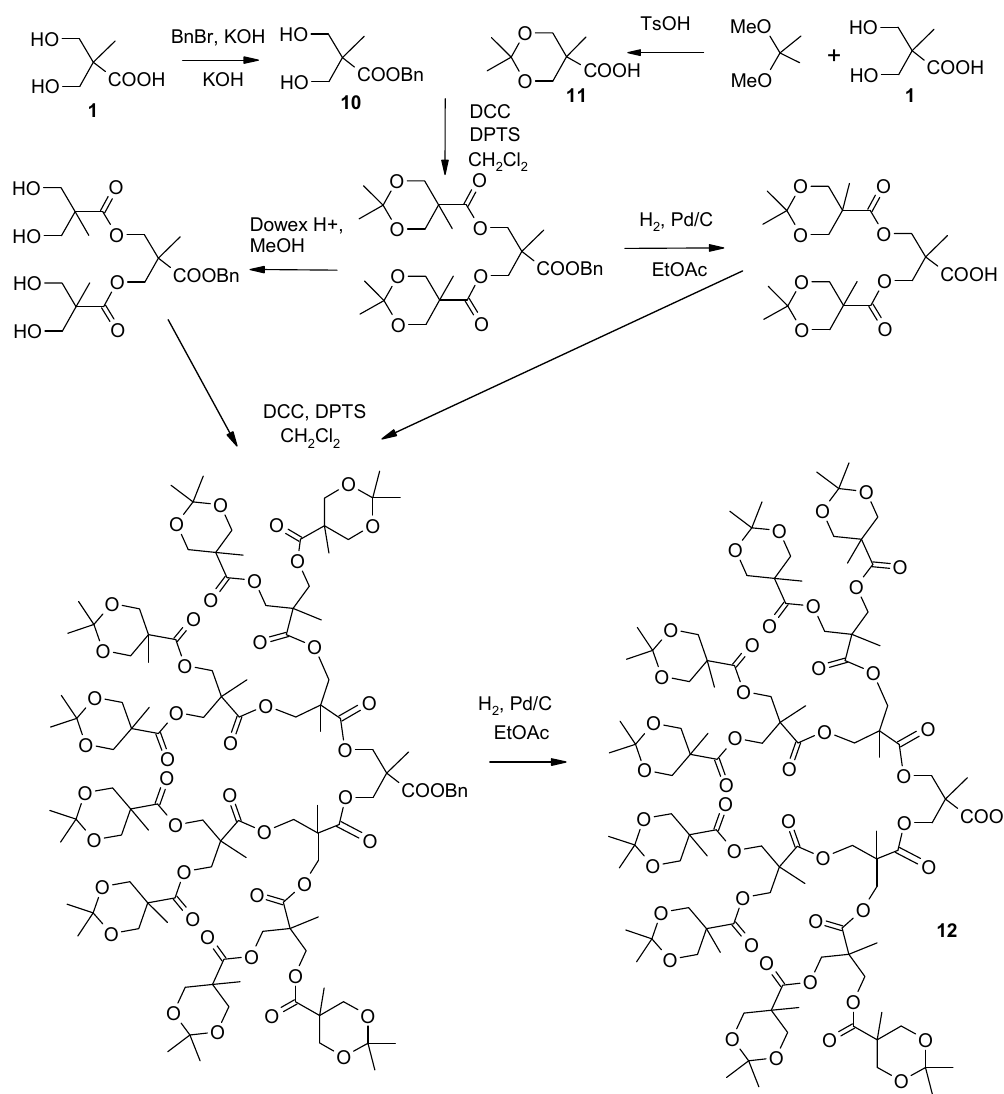
Scheme 3. Double exponential dendron growth